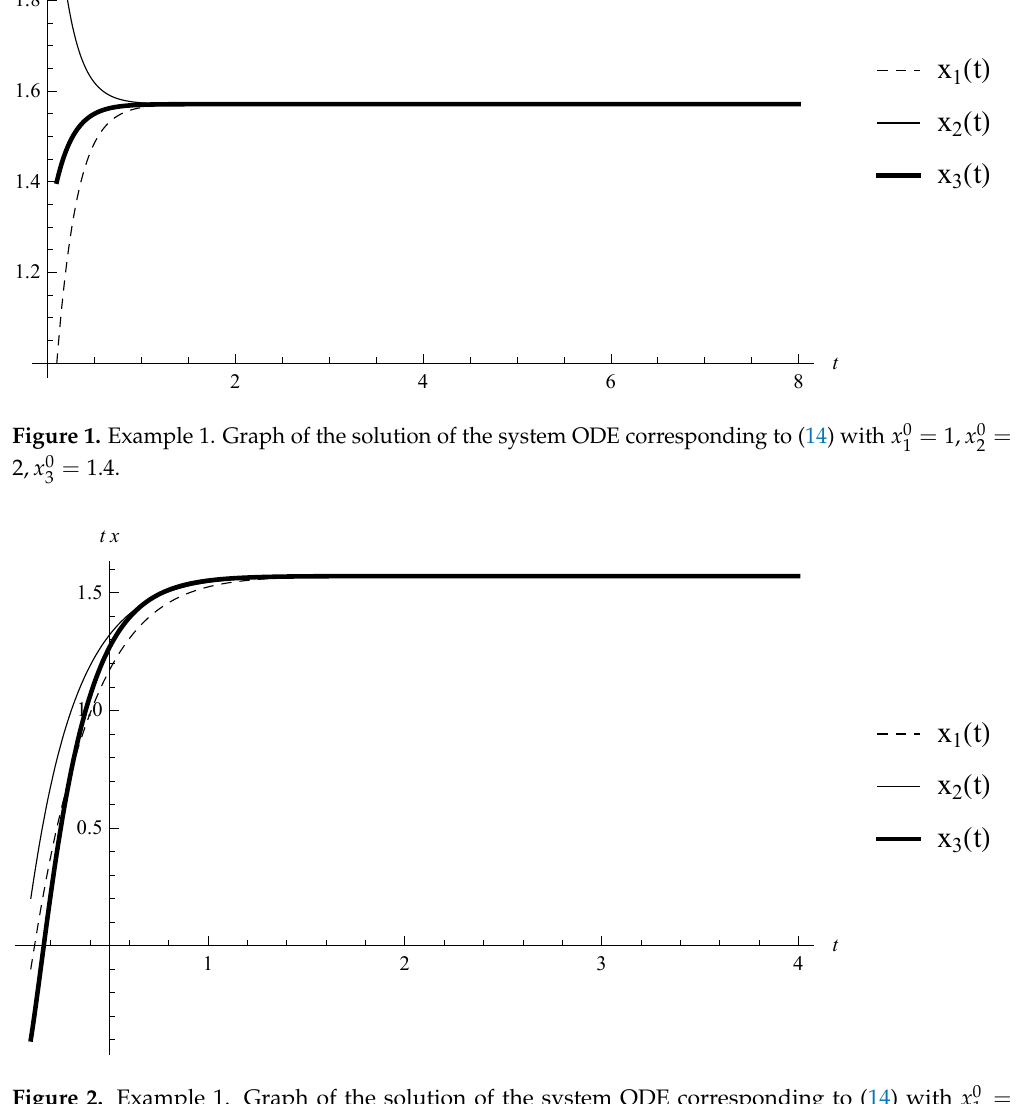
Figure 2. Example 1. Graph of the solution of the system ODE corresponding to (14) with x 0 − 0.1, x 0 = 0.2, x 0 = − 2 3